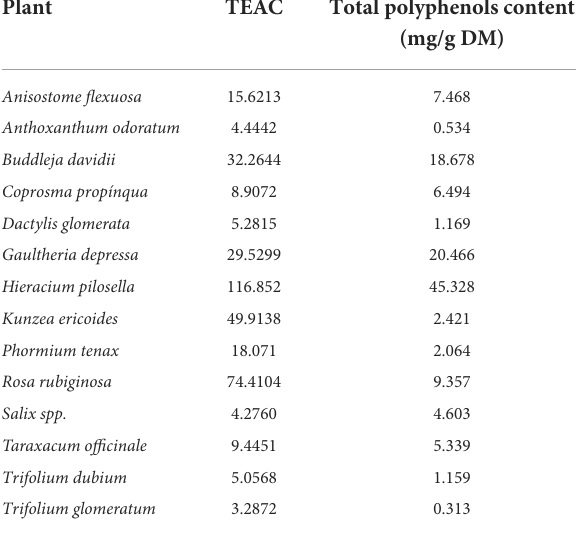
TABLE 4 The diphenyl-1-picrylhydrazyl radical scavenging activity, expressed as the TROLOX equivalent antioxidant capacity (TEAC), and total polyphenols content of 14 plants purposely selected in terms of phytochemical and nutraceutical composition. Plant